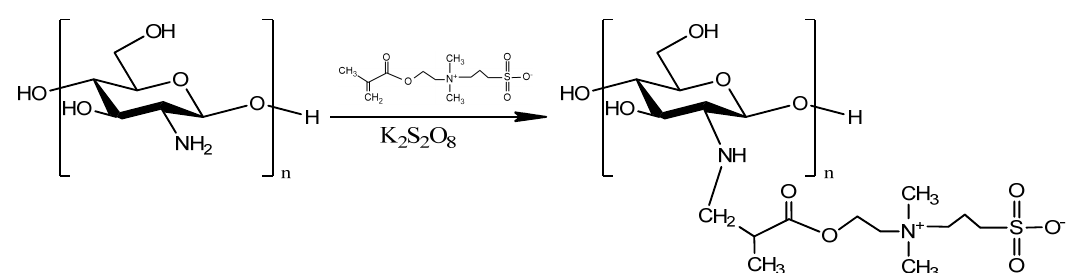
Figure 1. Chemical modification of chitosan with 2-(methacryloyloxy)ethyl]dimethyl-(3-sulfopropyl) ammonium (SDAEM).